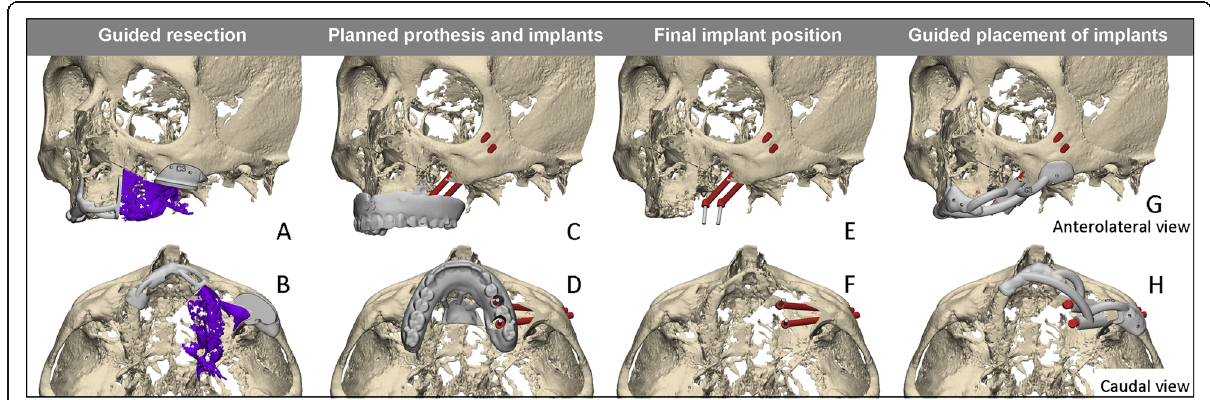
Fig. 1 Overview of 3D VSP workflow, including the anterolateral view (upper row) and the matching caudal view (lower row). The 3D VSP starts with planning of the maxillectomy including the design of the cutting guide, with which the aim is to remove the purple part representing tumor removal ( a , b ). Hereafter the obturator prosthesis position is planned in the defect with the pre-planned screw access holes ( c , d ). The positions of the zygomatic implants are planned backward from this optimal position of the obturator prosthesis ( e , f ). The final step includes the design of the drilling and placement guide of the zygomatic implants ( g , h